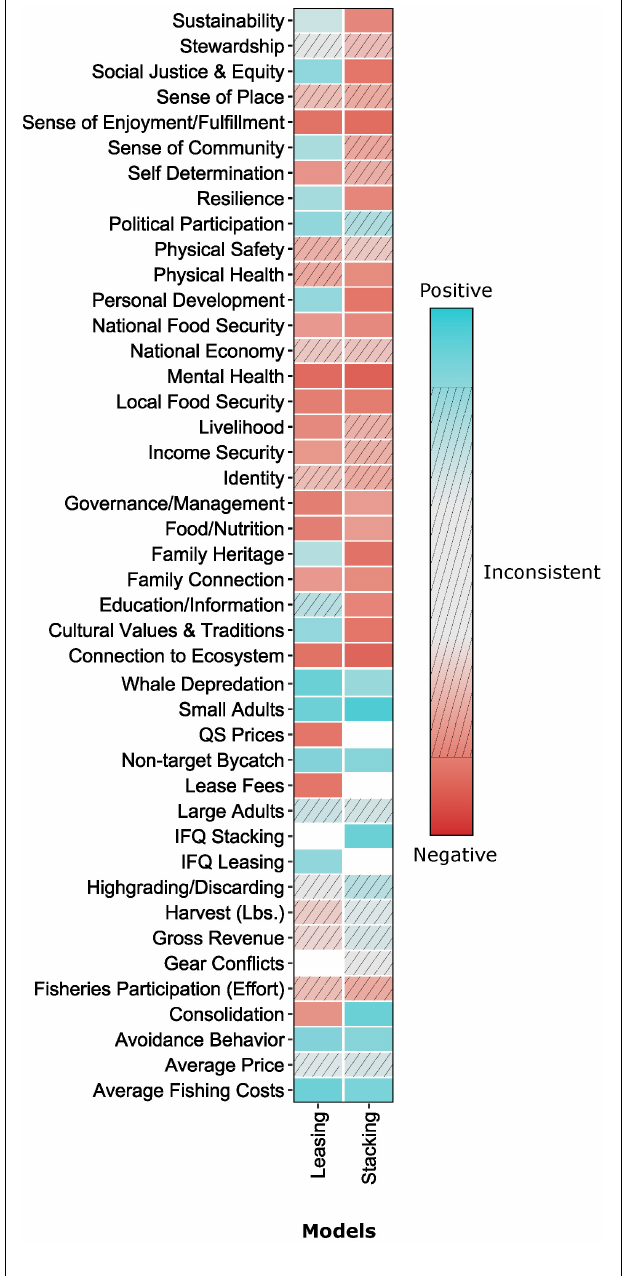
FIGURE 9 | Results from 10,000 simulations to a positive perturbation in small adults and whale depredation for the leasing IFQ and stacking IFQ models. The squares indicate the probability of a positive (blue) or negative (red) response of the variables ( y -axis) within each model ( x -axis). Shading increase corresponds with an increase in sign consistency and the textured squares represent inconsistent results that are less than the 70% cutoff Figure created with R package “ggplot2” (Wickham, 2016; R Core Team,